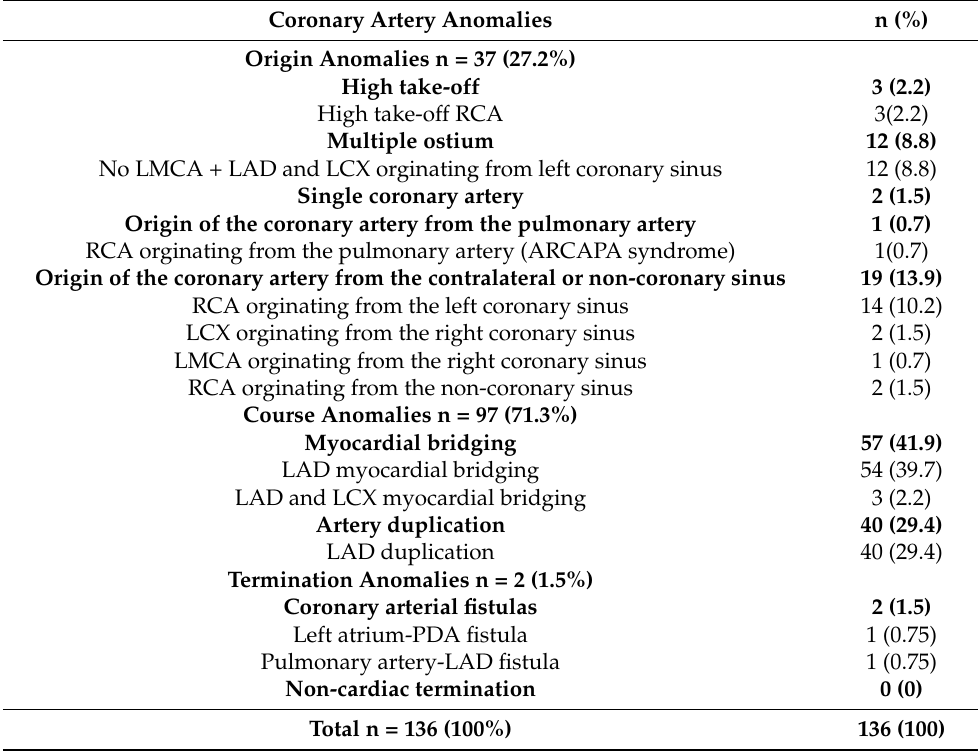
Table 2. Types and percentage distributions of coronary artery anomalies of the patients. Coronary Artery Anomalies